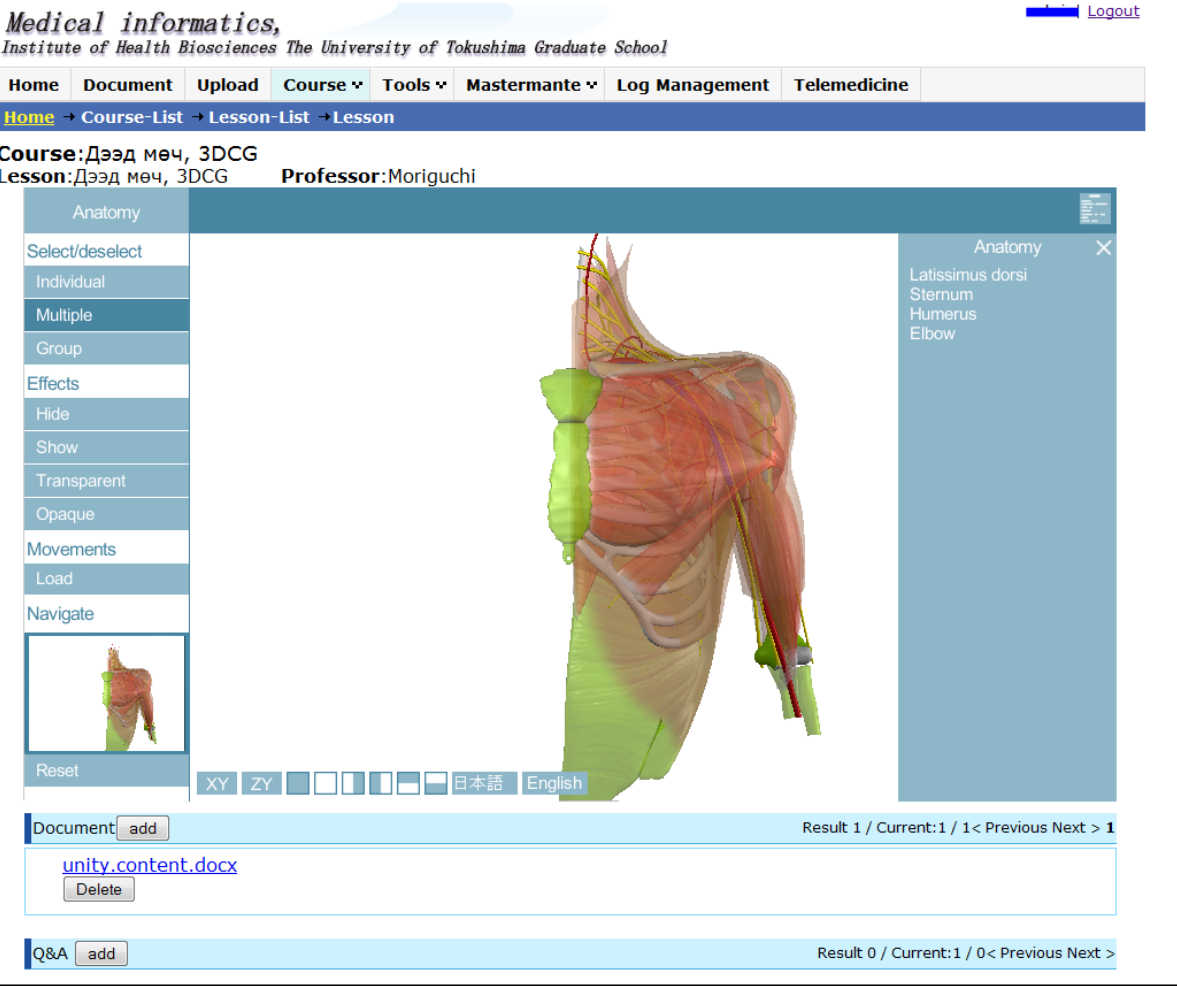
Figure 1. Anatomical view of the 3-dimensional computer graphic showing the shoulder